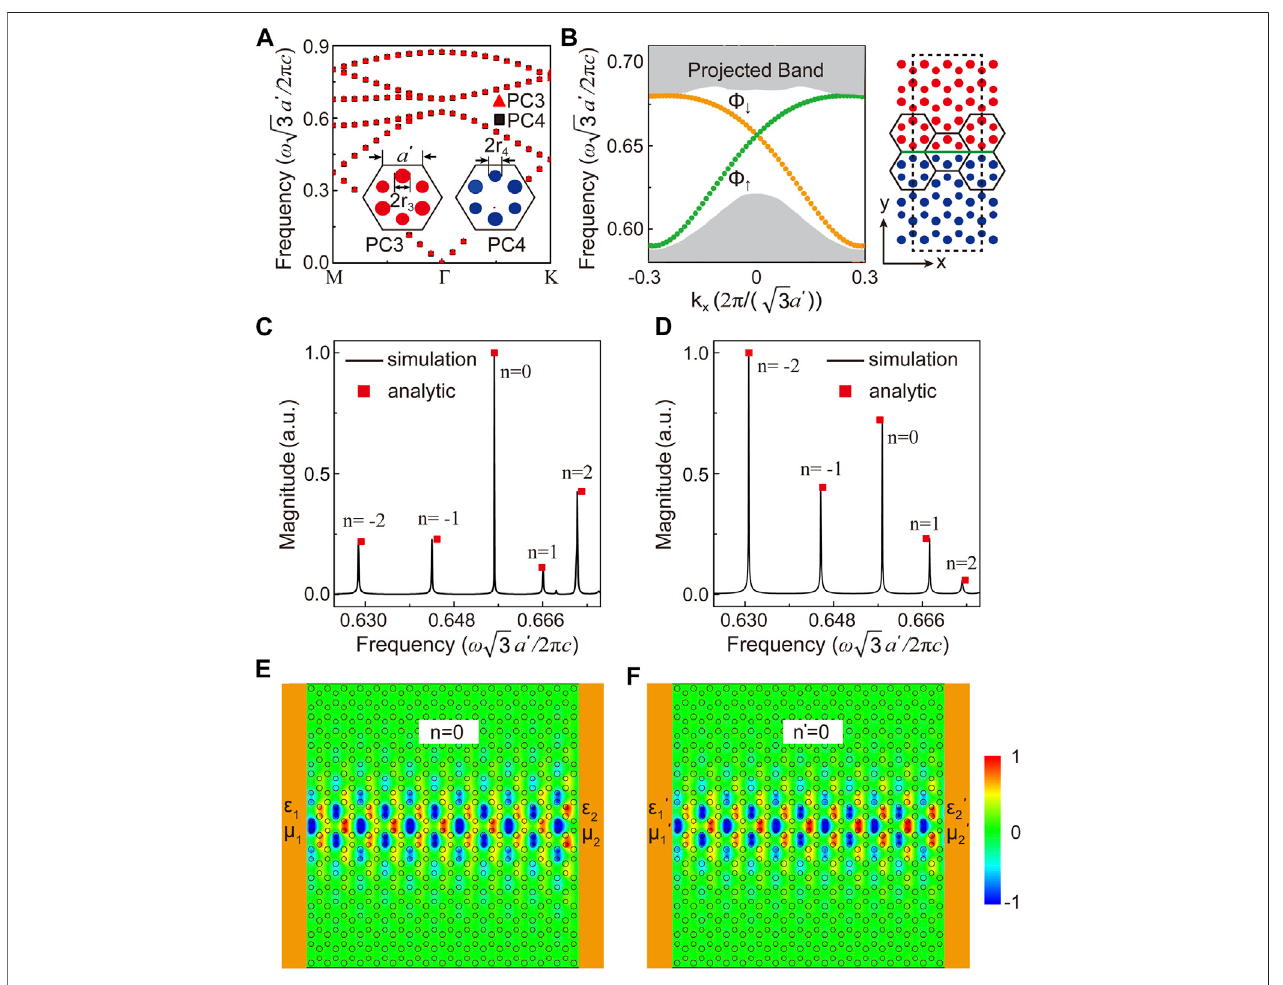
FIGURE 4 | (A) Calculated bulk TM photonic band diagrams of PC3 and PC4. As the diameters of cylinders in a unit cell are not identical in both PC3 and PC4 ( r 3 (cid:1) 0 . 176 a ’ , r 4 (cid:1) 0 . 147 a ’ , and ε ’ diel (cid:1) 7 . 5), a photonic bandgap appears by sublattice symmetry breaking. (B) The projected band structure consists of fi ve unit cells for both PC3 and PC4 along the y direction, shown in the right panel. The folded bulk bands belonging to PC3 or PC4 are painted in gray, whereas the two topological interface bands are shown by yellow dots. (C,D) The received transmission spectra for different effective medium slabs ( ε 1 (cid:1) − 5 , μ 1 (cid:1) 1; ε 2 (cid:1) 5 , μ 2 (cid:1) − 1 and ε ’ (cid:1) − 6 , μ ’ (cid:1) 1; ε ’ (cid:1) 1 . 5 , μ ’ (cid:1) − 1) serving as two cavity mirrors, respectively. (E,F) Simulated E 1 1 2 2 (normalized to its own maximal